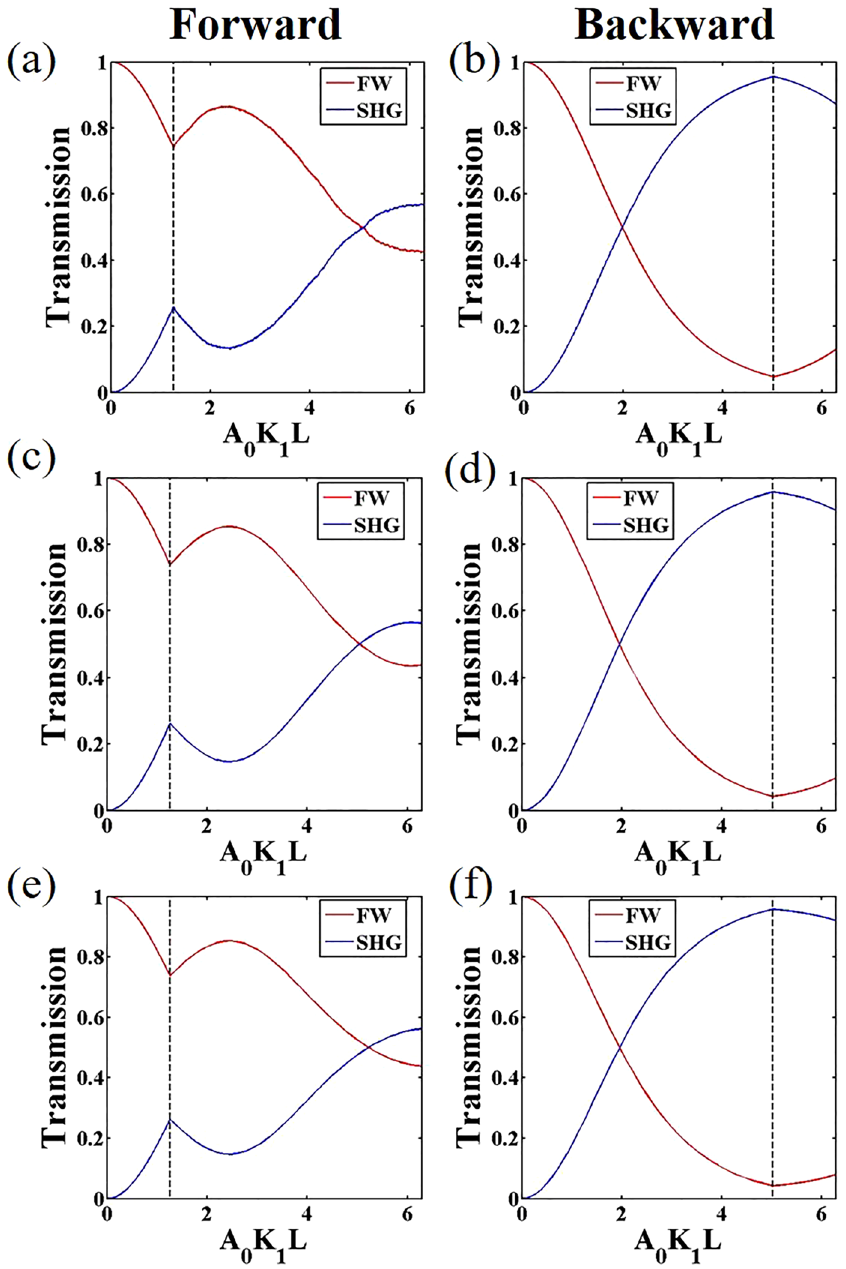
Figure 2. Normalized amplitudes of FW and SHW for the forward and backward processes in the defective NPC. ( a – f ) are the corresponding forward and backward propagations calculated on the basis of the original coupled equations, the simplified coupled equations and the analytical solutions,